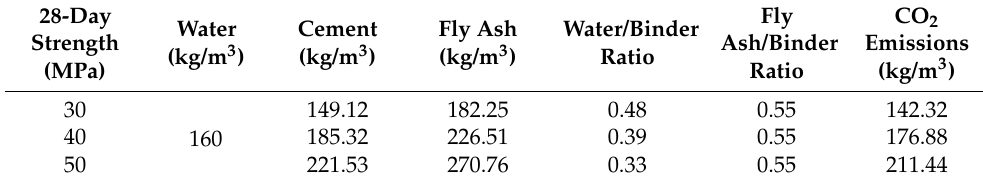
Table 1. Optimal results for low-CO 2 concrete of example 1 (water content = 160 kg/m 3 ).